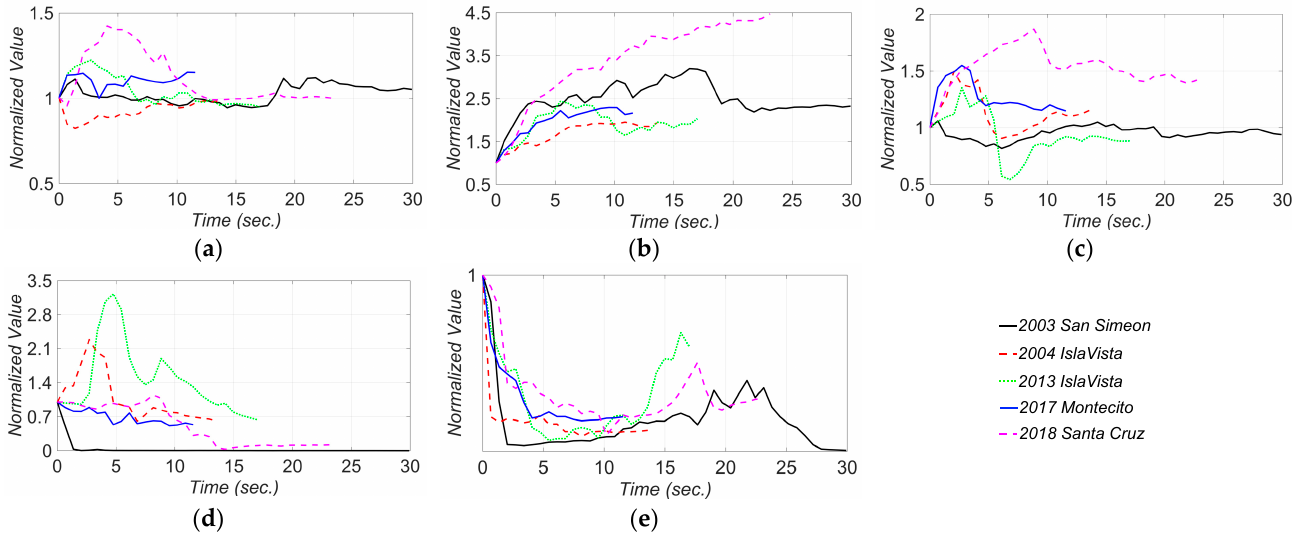
Figure 12. Estimation time histories of ( a ) (cid:1831) (cid:3028)(cid:3049)(cid:3032) , ( b ) (cid:1863) (cid:3013)(cid:3029) , ( c ) (cid:1863) (cid:3021)(cid:3029) , ( d ) (cid:1853) (cid:2868) , and ( e ) (cid:1853) (cid:2869) for different earthquakes. The estimates are normalized to the initial estimates.